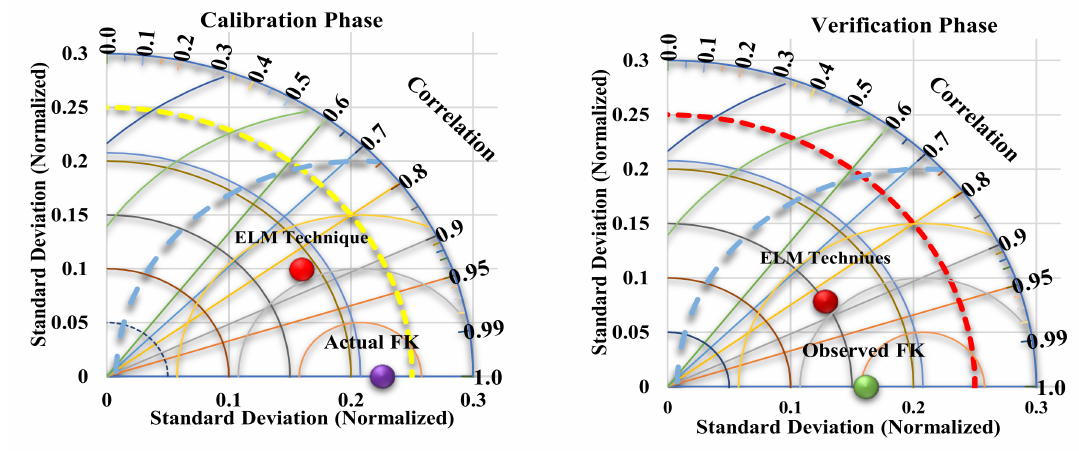
Figure 17. Taylor graphical representations of ensemble